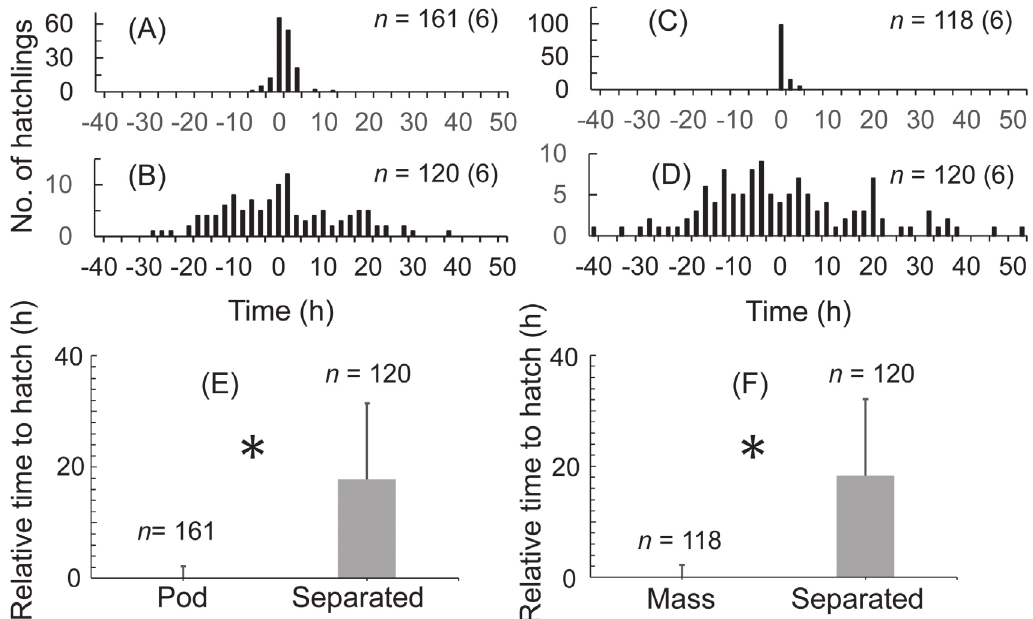
Fig. 2. The effects of egg separation on hatching patterns of Locusta migratoria eggs. The frequency distribution of hatching times for eggs kept in the pods ( A ) or in masses of 20 eggs ( C ) and those kept as separated eggs ( B, D ) when the mean hatching time was assumed to be 0 h. The relative times of hatching for the eggs kept in the pods ( E ) or in masses of 20 eggs ( F ) and those kept as separated eggs when the mean value for the former eggs was designated as 0 h. The number of hatched eggs followed by the number of tested pods in parentheses is given in each panel. Asterisks indicate a significant difference between the two treatments (p < 0.05;